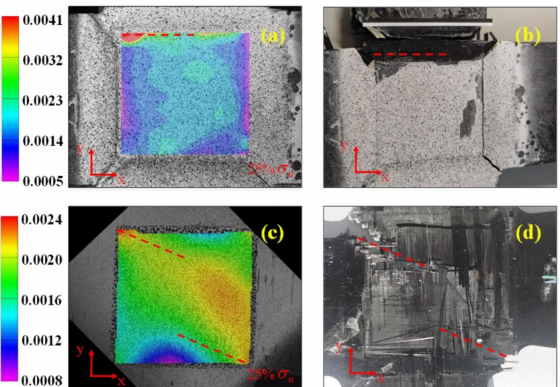
Figure 9. Strain field and failure morphology of the cruciform specimens processed by milling ( a , b ) and ECLM ( c , d